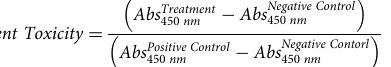
647 Phalloidin (Thermo Fisher) supplemented with 0.25% Triton X-100 for 20min at room temperature. Cells were rinsed with DPBS and stored in 65% glycerol at 4° C. Images were acquired using an EVOS FL microscope and analyzed using ImageJ. Double infection of HeLa cells and PNA treatment . For the double infection of HeLa cells with target STm (SL1344-mCherry) and delivery STm (SL1344-holin) (Fig. 4d-f), single colonies were picked on solid media and grown overnight in 1 mL of LB broth supplemented with 30 µg/mL streptomycin and 100 µg/mL ampicillin. Overnight cultures were diluted 1:10 and regrown for 3h. After regrowth the cultures were washed thrice with PBS and diluted to a concentration of 9 ×10 6 CFU/mL (MOI of 10). The SL1344-holin infection stock was split into no treat- ment and treatment; 10µM of recA was added to the treatment condition and an equal volume of PBS was added to the no treatment. Both conditions were incu- bated for 45 min at 37 °C mimicking the conditions used in the single infection experiment for the PNA to enter the Salmonella . After incubation all infection stocks (target STm, delivery STm with no treatment, and delivery STm with treatment) were washed thrice with DPBS to remove any extracellular PNA. Each delivery-STm and target STm stock was combined at a 4:1 ratio to create the treatment and no treatment infection solutions and 50 µL was to infect the HeLa. To ensure that the incubation ratio remained the same and PNA waste was minimized the DPBS washes were done with volumes under 1mL resulting in variability of the actual MOI infected of each infection stock. To account for this variability each infection stock was serially diluted, plated, grown overnight, and CFUs counted to determine the exact number of bacteria that was used to infect for each condition. This extracellular CFU causing infection was measured for both delivery STm and target STm using fl orescence and is referred to as CFU Infected With Delivery STm and CFU Infected With Target STm respectively. For CFU counting the separate bacterial populations were separated by counting the Target STm as those colonies that fl uoresced when excited by light at 587 nm in a light box and viewed through a 610 nm emission fi lter, and the delivery STm as colonies showing lack of fl uorescence at those wavelengths. At 18 h post infection wells for CFU analysis were washed thrice with 300 µL PBS and lysed with 30µL of 0.1% Triton X-100 for 15min at room temperature. After 15 min, 270 µL of PBS was added to each well then serially diluted and plated on sold LB media supplemented with 40 µg/mL streptomycin. Plates were incubated for 16h at 37°C and CFU per milliliter determined. The intracellular CFU post lysis was measured for both SL1344-holin and target